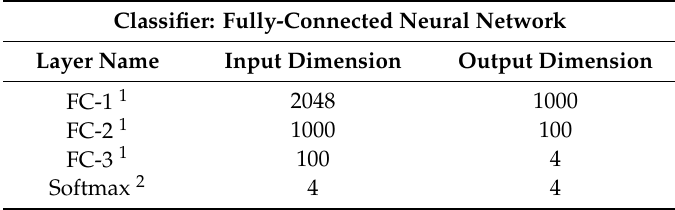
Table 3. Architecture of fully connected network in our pattern classification